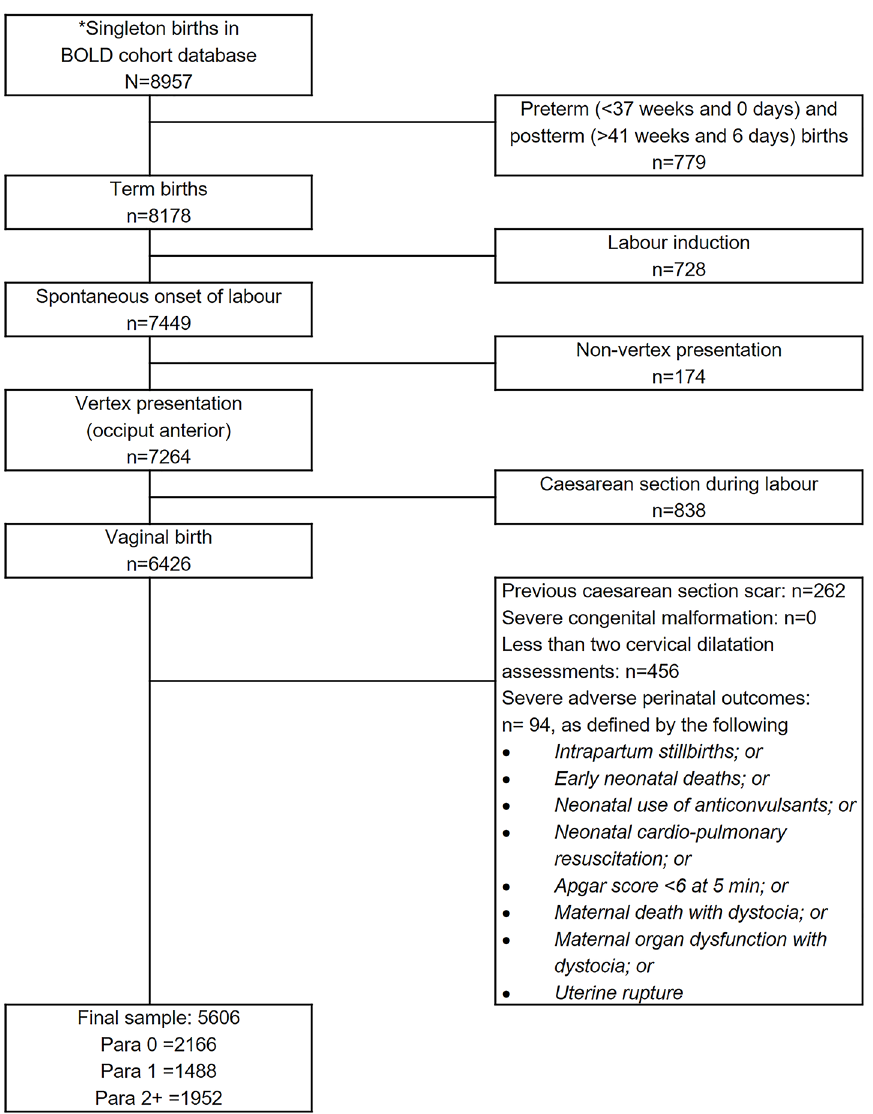
Fig 1. Sample selection flow chart. (cid:3) Excluding significant outliers due to unusual rapidity, regression, or inconsistencies with time. BOLD, Better Outcomes in Labour Difficulty.